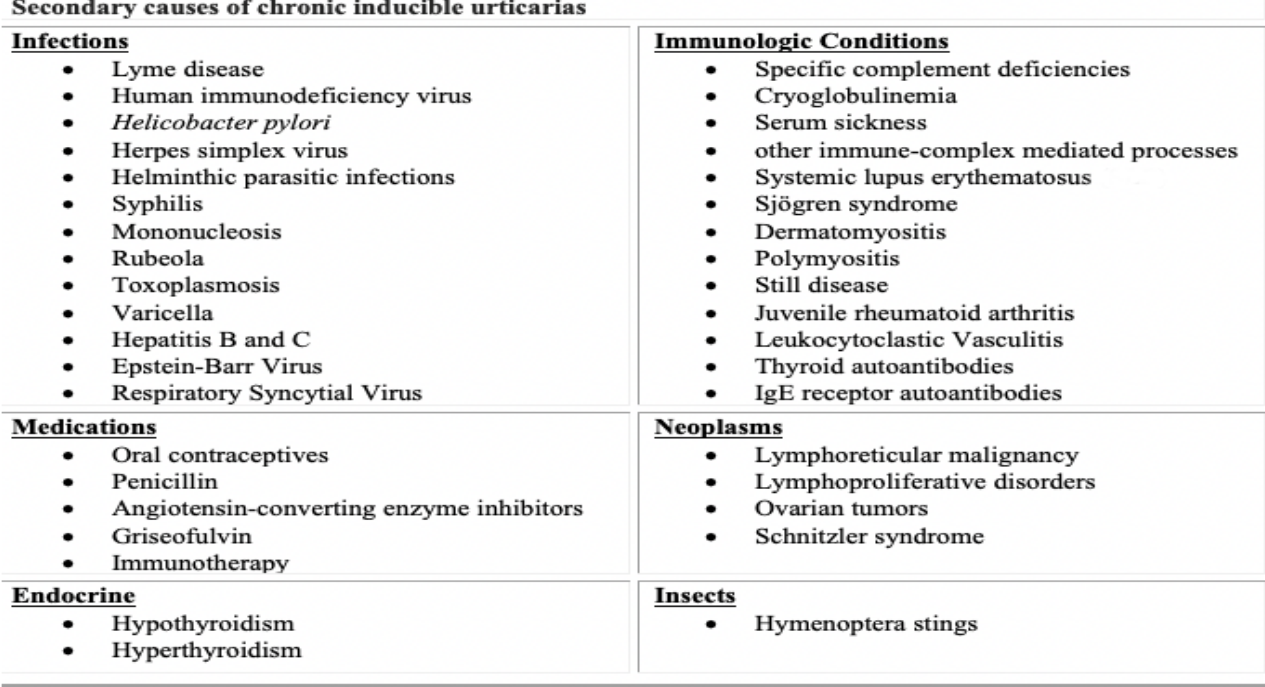
Figure 2. Secondary causes of chronic inducible urticarias. 2,7,12,15 Ig ,